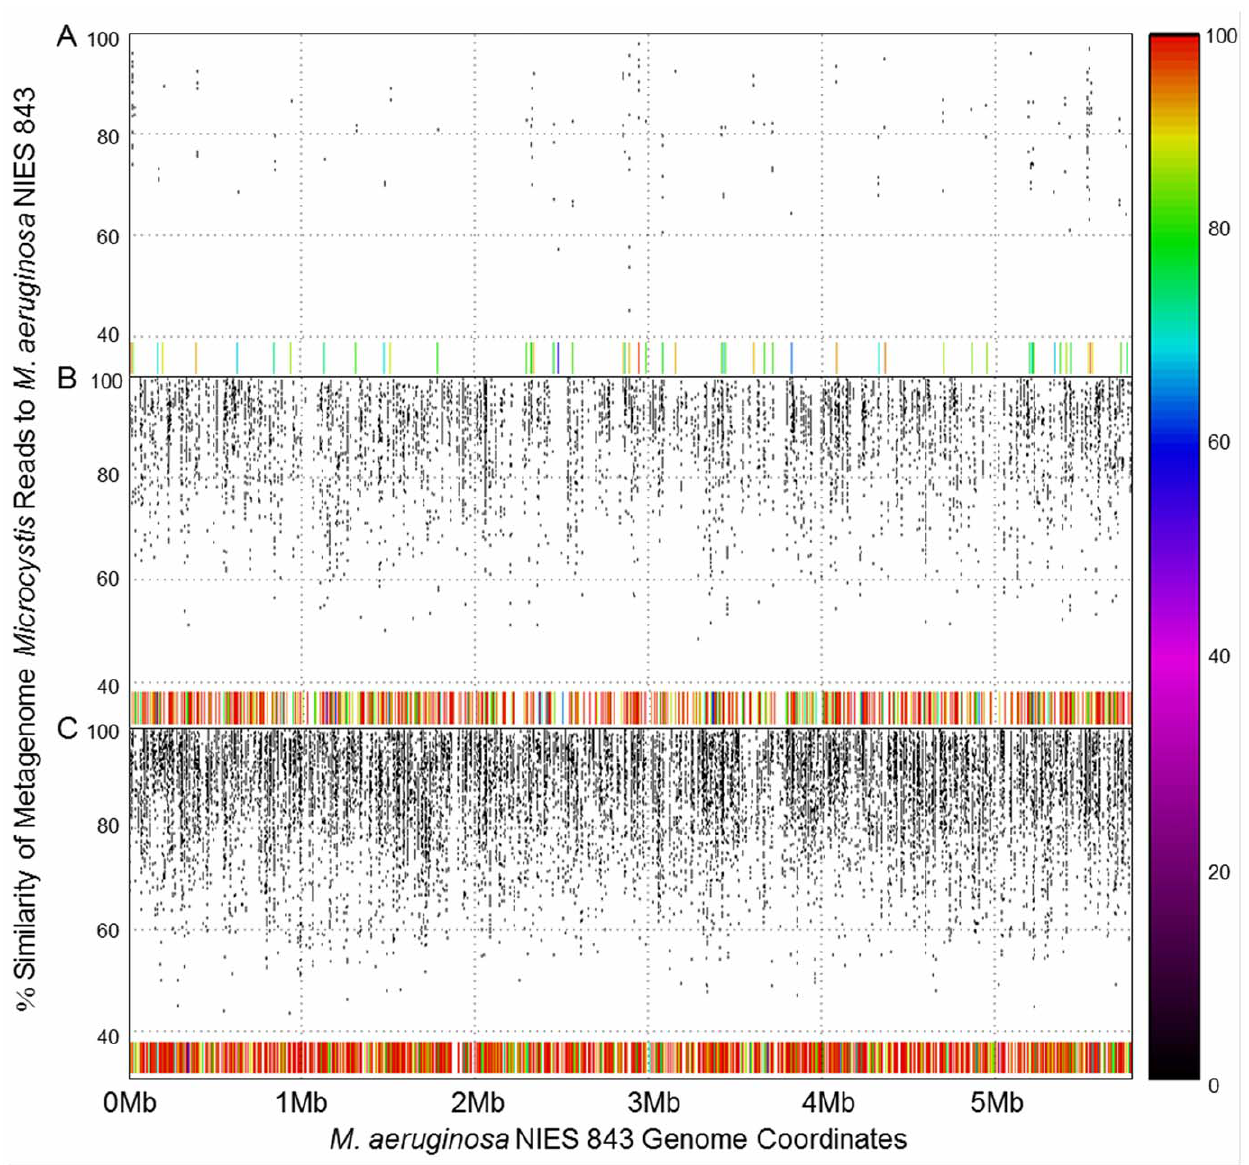
Figure 1. Recruitment plots of metagenomes to Microcystis aeruginosa NIES 843. Recruitment plots of environmental Microcystis reads from each metagenome to the M. aeruginosa NIES 843 genome. A) Recruitment of GLSM Microcystis reads to NIES 843. B) Recruitment of Taihu Microcystis reads to NIES 843. C) Recruitment of Erie Microcystis reads to NIES 843. Position along the x-axis indicates position along the genome of M. aeruginosa NIES 843 from zero to 5.8 Mbp and position along the y-axis indicates percent similarity of recruited sequences. The bar along the bottom is a secondary indicator of percent similarity to the reference genome. See Table S2 for locations of potential MI’s within each recruitment. doi:10.1371/journal.pone.0044002.g001 RAST comparative analyses, the GenBank database was used for phylogenetic analysis and RefSeq was used to annotate functional genes using the parameters described above [37]. Phylogenetic comparisons were made using percent abundance within each library post quality control analysis. COG and functional gene comparative analyses were performed using reads normalized to the library with the greatest total number of hits to the COG database (Taihu). Sequences generated in this study are available on the MG-RAST online server (http://metagenomics.anl.gov/)